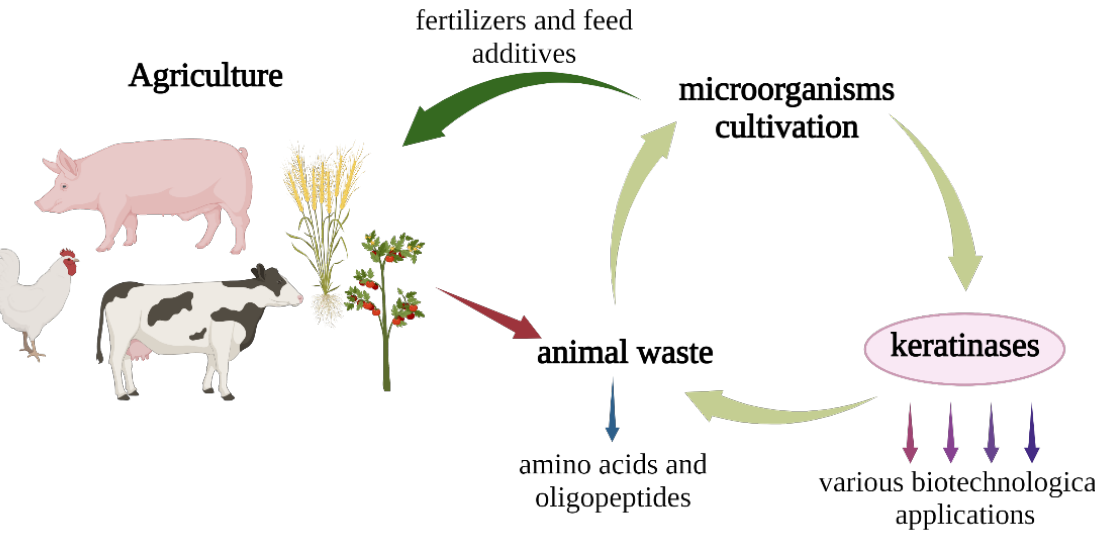
Figure 12. The scheme of closed-loop agriculture using keratinolytic microorganisms for animal waste biodegradation (created with BioRender.com, access date: 9 November 2021).